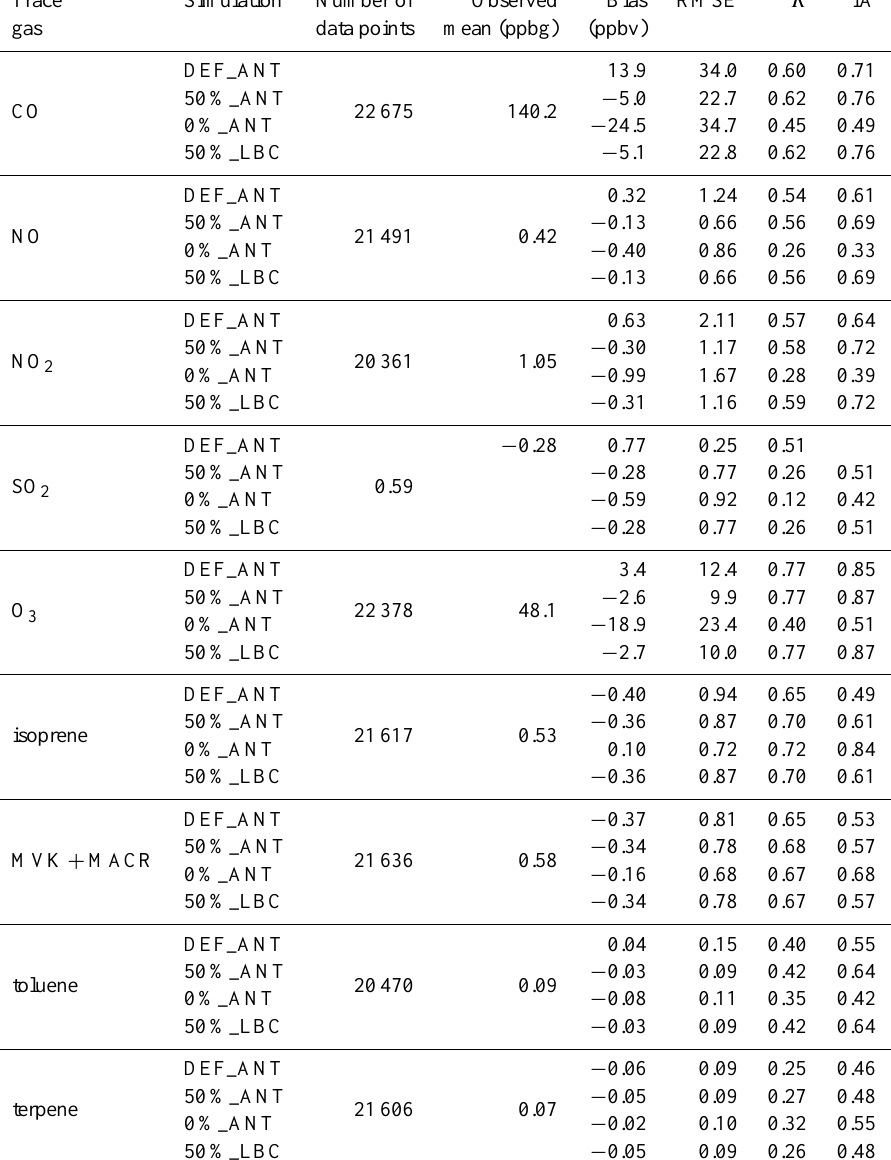
Table 8. Performance of simulated carbon monoxide (CO), nitrogen oxide (NO), nitrogen dioxide (NO 2 ) , sulfur dioxide (SO 2 ) , ozone (O 3 ) , isoprene, methyl-vinyl-ketone + methacrolein (MVK + MACR), toluene, terpene, and formaldehyde over all the G-1 flights in terms of bias, root-mean-square error (RMSE), correlation coefficient ( R ), and index of agreement